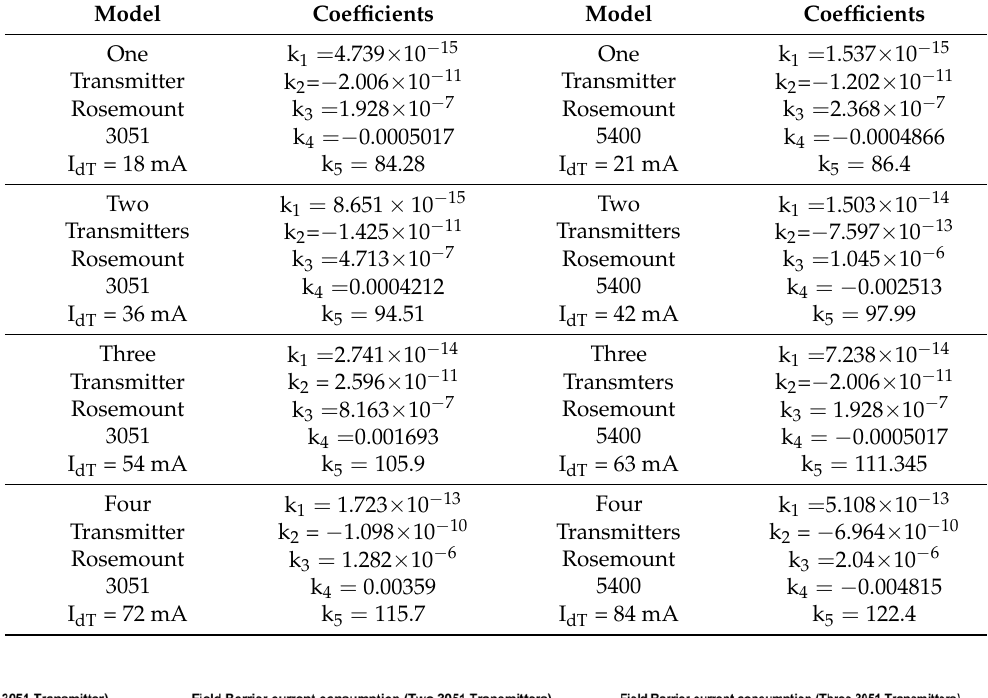
Table 2. Table indicating values of the coefficients for the polynomial Equation (10) defining the relation between the current consumed by the field barrier and H1 trunk cable length in each of the models illustrated in Figure 6a,b. Coefficients k1 in mA/ m 4 , k2 in mA/ m 3 , k3 in mA/ m 2 , k4 in mA/m and k5 in mA.